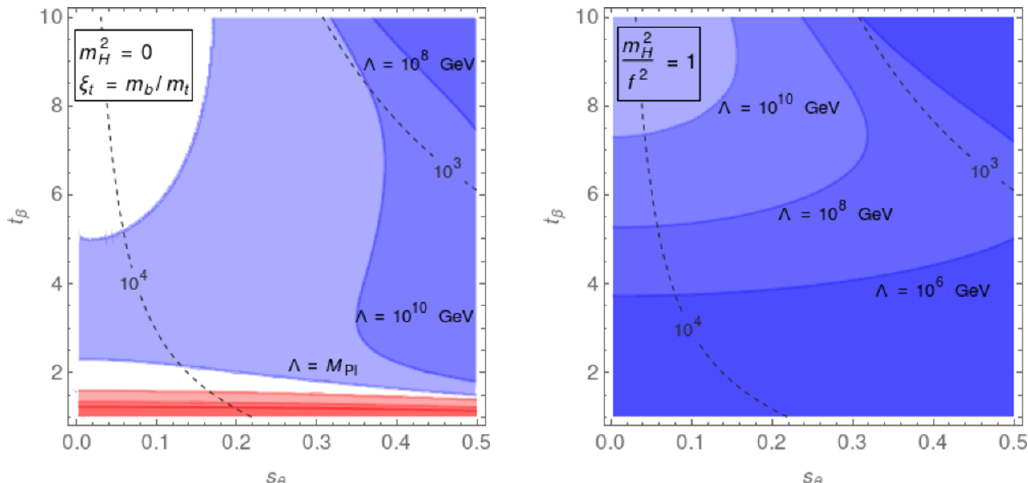
Figure 5 . Corresponding plots to (cid:12)gure 3 with (cid:24) t = m b =m t . On the unshaded area (cid:3) (cid:21) M Pl . The dashed lines show the values of 4 (cid:25)f in